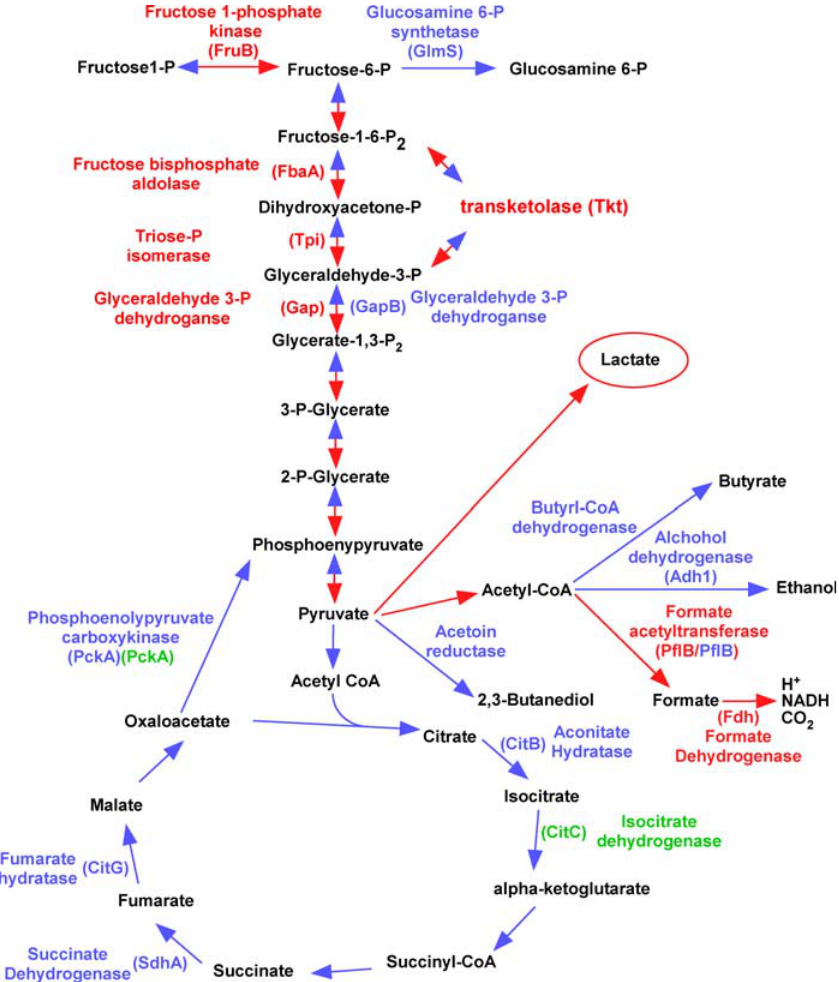
Figure 3. Lactate Is a Primary End-Product of Carbohydrate Metabolism by Iron-Starved S. aureus A subset of the predicted central metabolic reactions of S. aureus is shown. Proteins shown in red are up-regulated in the absence of iron or upon inactivation of fur . Proteins shown in blue are down-regulated in the absence of iron or upon inactivation of fur . Proteins shown in green are down- regulated in the absence of Fur independent of iron status. The red arrows predict the direction of reactions upon iron starvation, while the blue arrows predict reactions that are inhibited upon iron